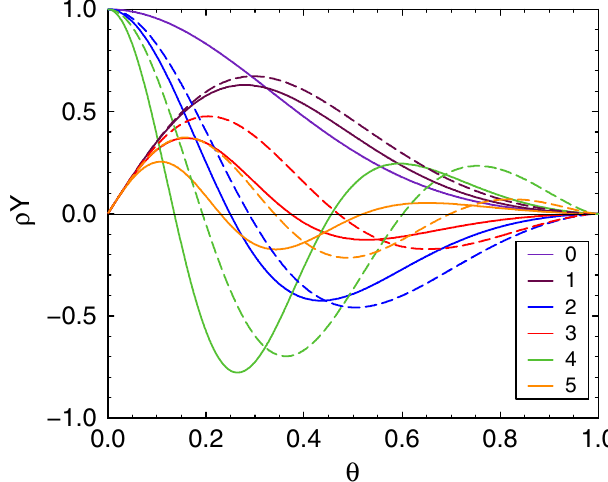
FIG. 8. (Color) Eigenfunctions of the Gaussian bunch at higher (cid:7)